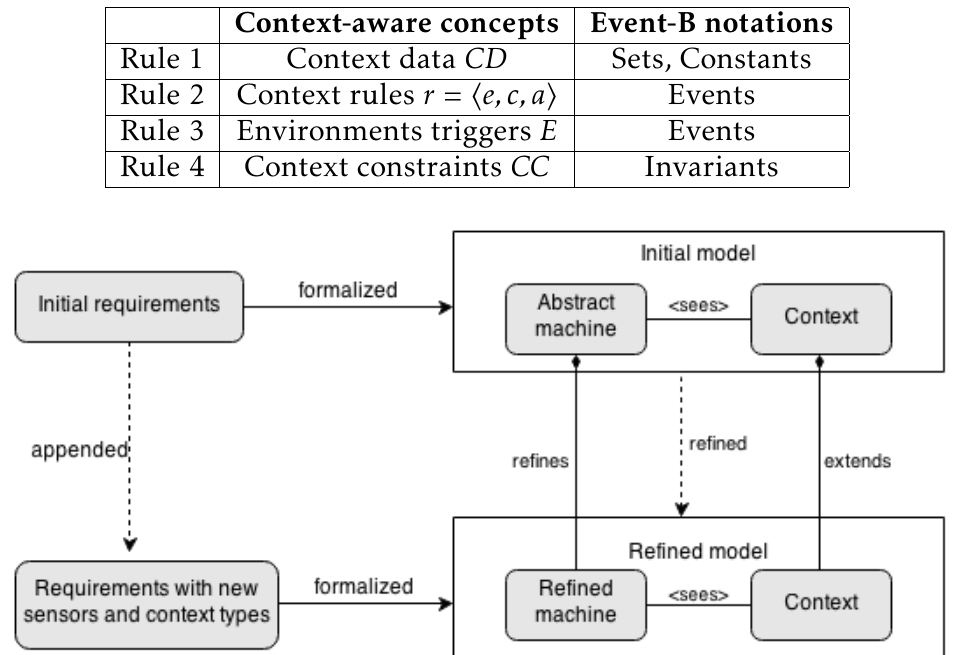
Table 2. Transformation between context-aware systems and Event-B notations